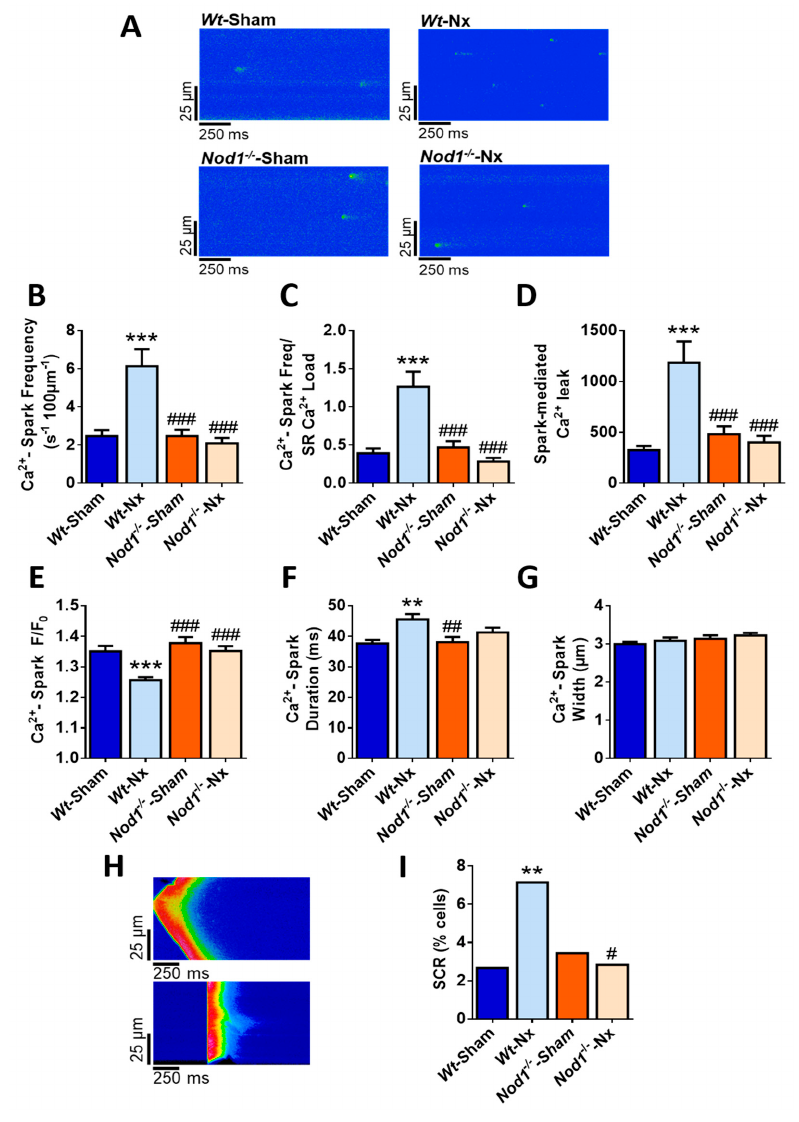
Figure 2. Prevents the increased frequency of Ca 2 + -sparks and spontaneous Ca 2 + release (SCR) induced by 5 / 6 nephrectomy. ( A ) Representative line-scan confocal images of Ca 2 + sparks recordings obtained in a quiescent cardiomyocyte isolated from Wt -sham, Wt -Nx, Nod1 − / − -sham and Nod1 − / − -Nx mice. Average data of ( B ) Ca 2 + spark frequency, ( C ) normalization of Ca 2 + spark frequency by SR-Ca 2 + load, ( D ) spark-mediated Ca 2 + leak and Ca 2 + sparks properties: ( E ) peak, ( F ) duration and ( G ) width obtained in cells isolated from Wt -sham ( n = 45 cells / five mice), Wt -Nx ( n = 47 cells / five mice), Nod1 − / − -sham ( n = 40 cells/five mice) and Nod1 − / − -Nx ( n = 46 cells/five mice) mice. ( H ) Representative line-scan confocal images of SCR recordings (Ca 2+ wave [upper panel]; spontaneous Ca 2+ transients release (lower panel)) from cardiomyocytes isolated from Wt -Nx mice. ( I ) Average data of SCR occurrence obtained in cells isolated from all groups. Histograms show mean ± SEM. ** p < 0.01; *** p < 0.001 vs. Wt -sham; # p < 0.05; ## p < 0.01; ### p < 0.001 vs. Wt -Nx.